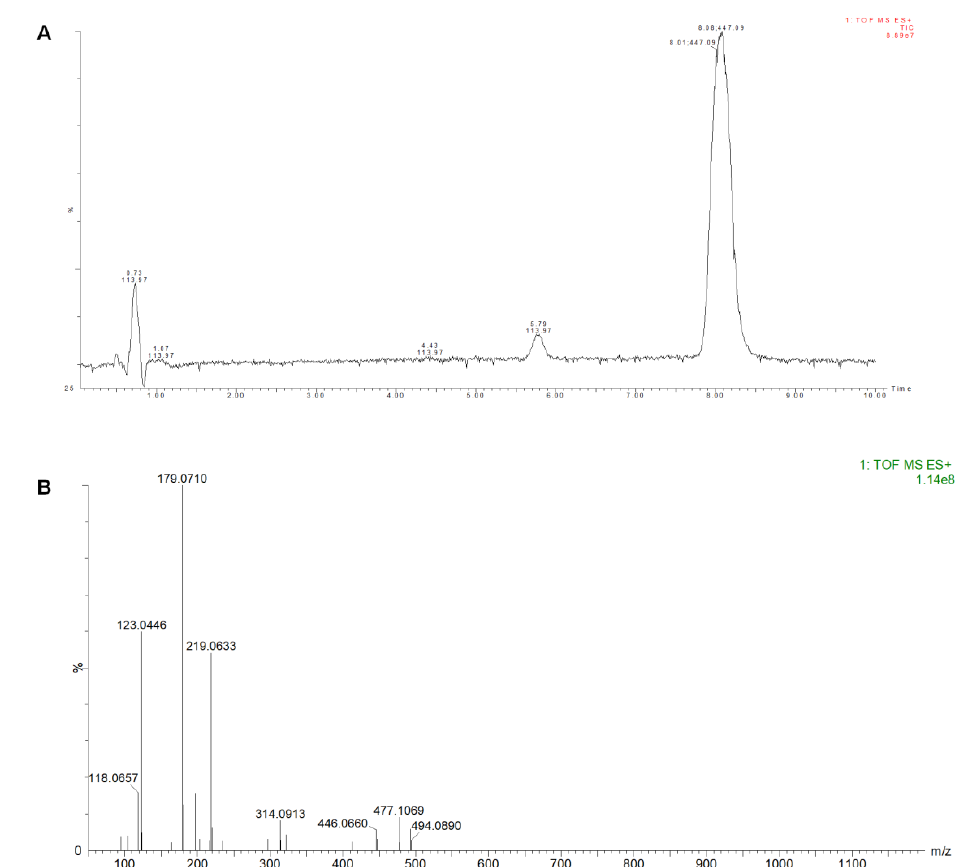
+ mass spectra ion